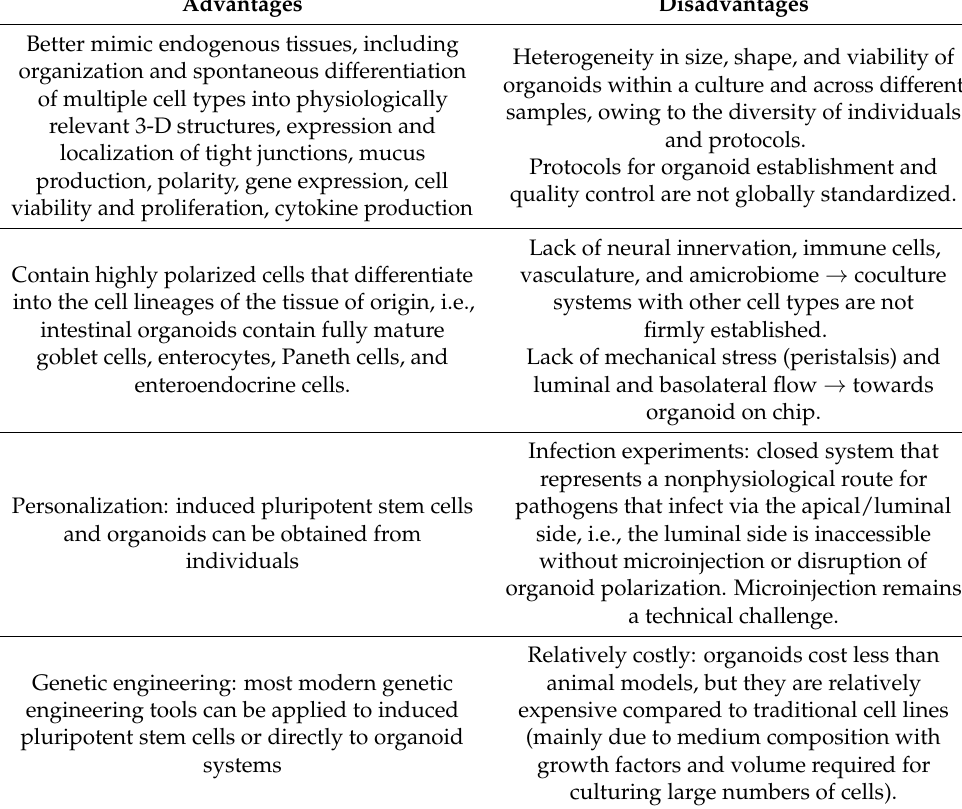
Table 2. Main advantages and disadvantages/limitations of 3D cell cultures (as reviewed in